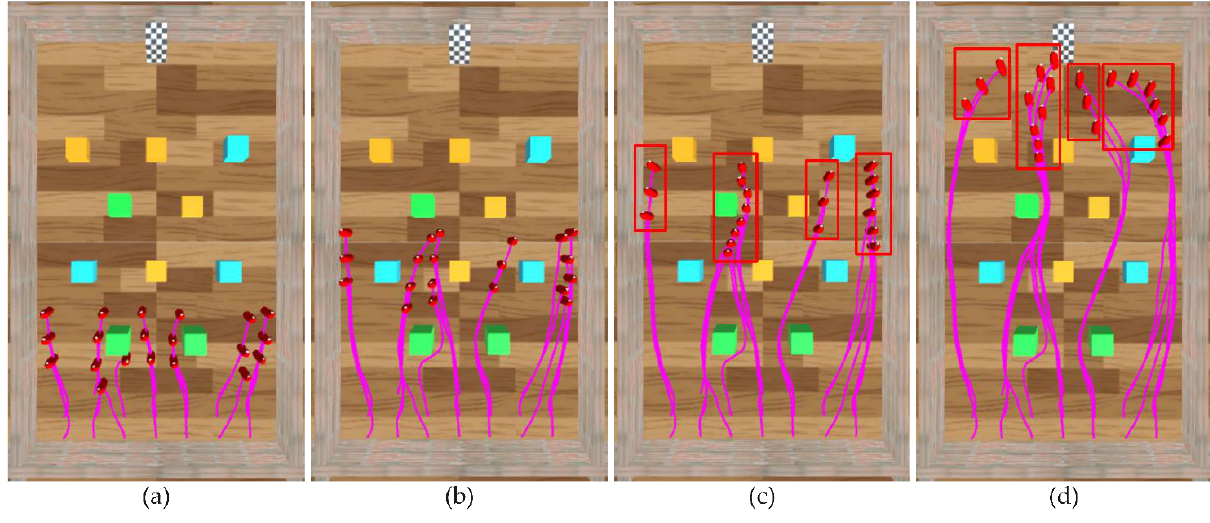
Figure 9. A temporal sequence of an experimental result generated by the method of [27] in sce- nario II. ( a – d ) Stills of the experimental result. The temporal sequence of these stills is sorted al- phabetically.